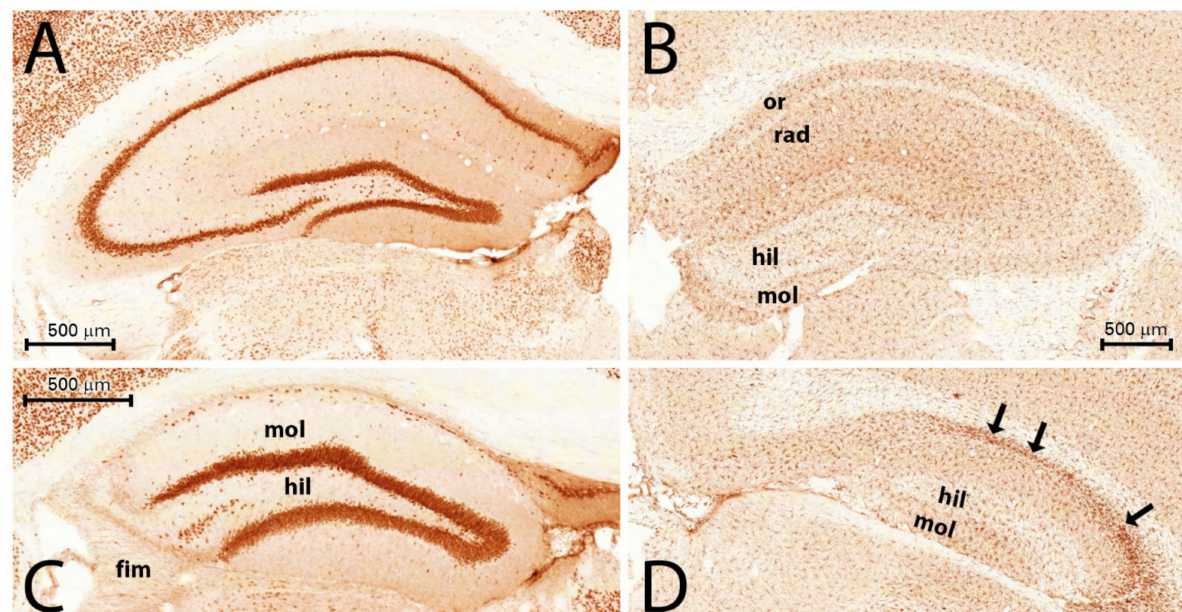
Figure 1. Neurons ( A , C ) and microglia ( B , D ) in control ( A , B ) and PT4 ( C , D ) hippocampi. NeuN staining ( A , C ) revealed complete loss of principal neurons in CA regions (PT4 animal ( C )). Iba1 staining revealed the accumulation of microglia cells (arrows in ( D ) in the sclerosed regions). Abbre- viations: mol = molecular layer of DG; hil = hilum of DG; or = stratum oriens; rad = stratum radiatum. Bars: 500 µ m (bar on ( B ) is for ( D )).